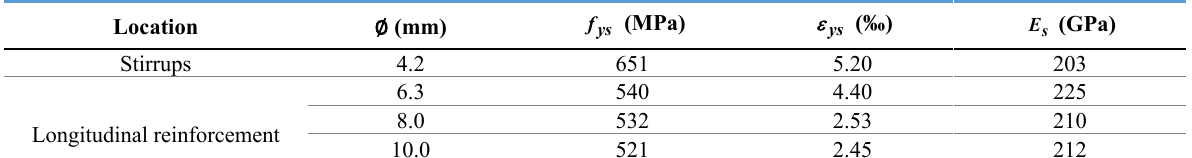
Table 2. Steel bars’ mechanical properties.